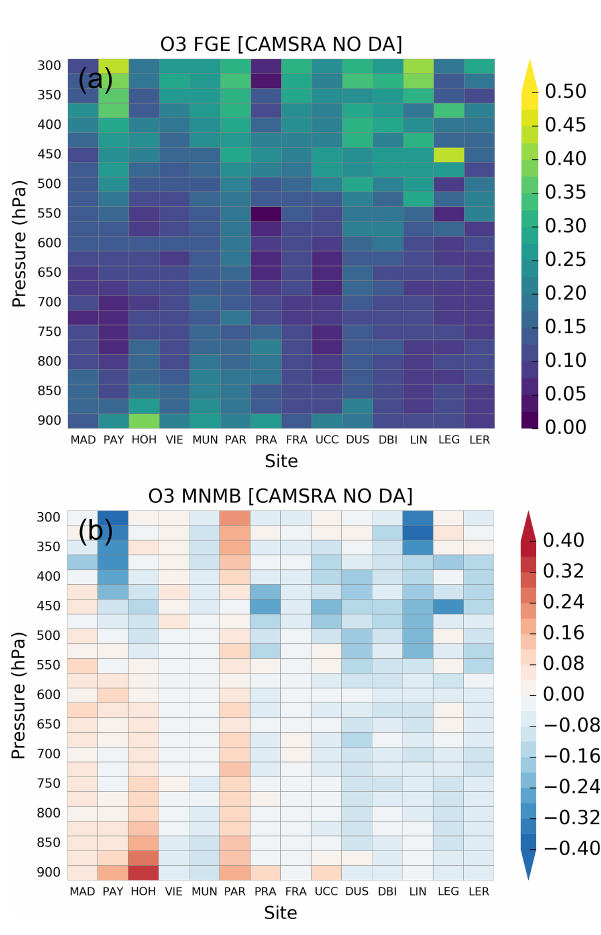
Figure 10. Vertical profiles of CAMSRA no DA ozone (a) FGE and (b) MNMB for the examined WOUDC ozonesonde stations and IAGOS airports over the period 2003–2018. The observational sites are ordered by increasing